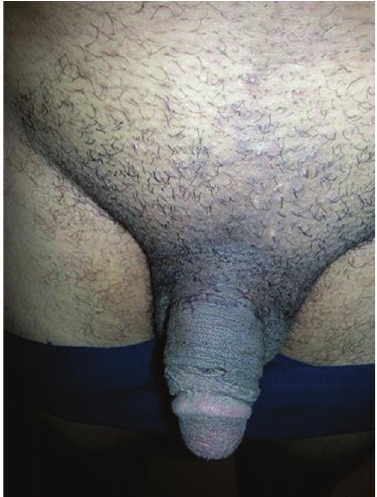
Figure 3: After 2 weeks of the